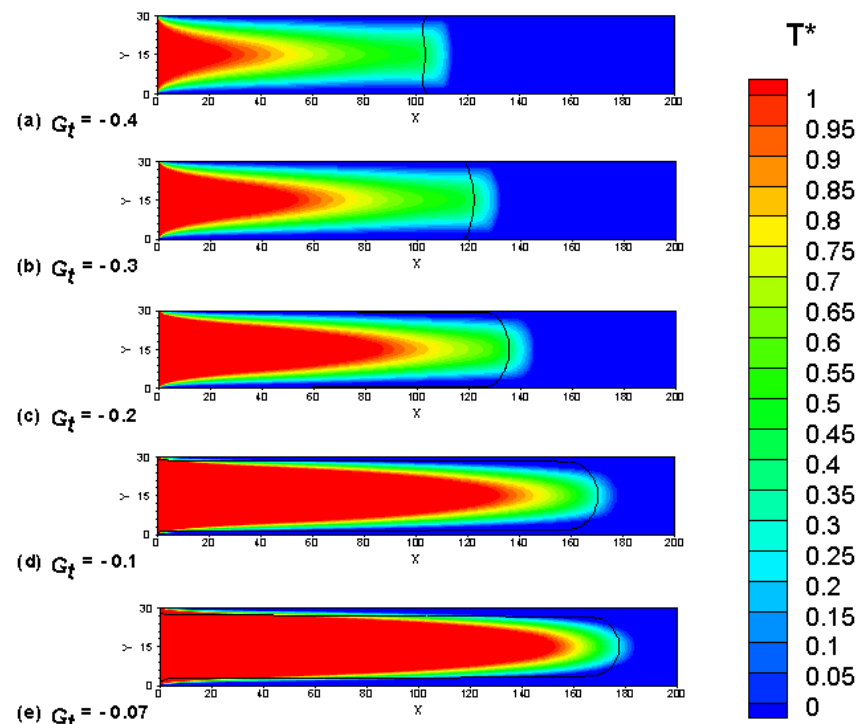
Figure 6. Dimensionless temperature distributions of channel flow with smooth surfaces at the 400th step ( 6.0  G ).